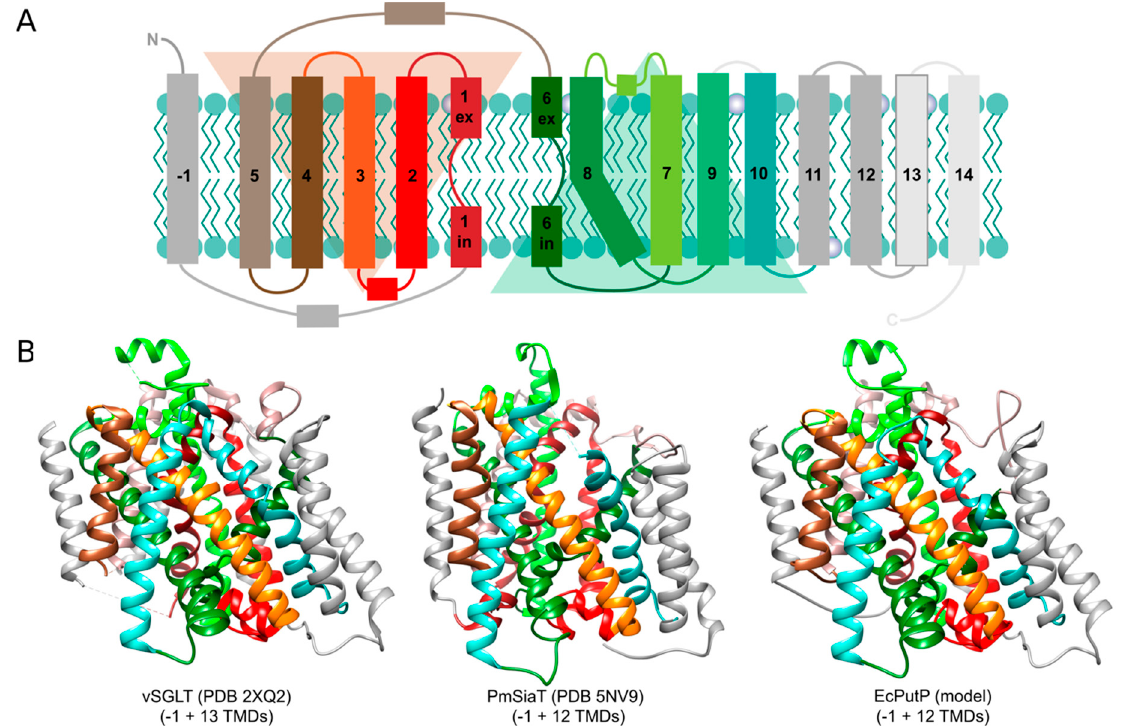
Figure 2. ( A ) Membrane topology of solute/sodium symporter (SSS) family transporters. SSS transporters are composed of 13 to 15 transmembrane domains (TMDs) connected by hydrophilic loops. The N terminus of the transporters is located on the outer site of the membrane. The transporters share the LeuT-type structural fold that is characterized by a core of ten TMDs that are arranged in five + five inverted repeats with an antiparallel orientation and a pseudosymmetry axis in the membrane plane [89]. The core domain starts at TMD 2 of SSS transporters (TMD 1 of SSS transporters is counted as TMD -1. ( B ) Ribbon representation of the three-dimensional structures of vSGLT, PmSiaT and EcPutP. The structures of vSGLT [84] and PmSiaT [64] are the result of X-ray analyses of respective crystals. The structure of EcPutP is based on homology modeling and experimental distance restraints obtained by site-directed spin labeling and EPR spectroscopy [90]. The figures were generated using UCSF Chimera. Chimera is developed by the Resource for Biocomputing, Visualization, and Informatics at the University of California, San Francisco [91]. ( A ) was taken and modified from Jung et al., 2012 [31].